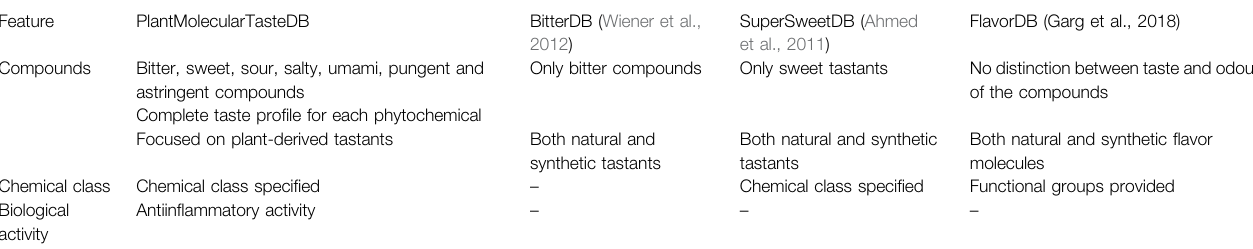
TABLE 1 | Comparison between various databases available on tastants and novelty of